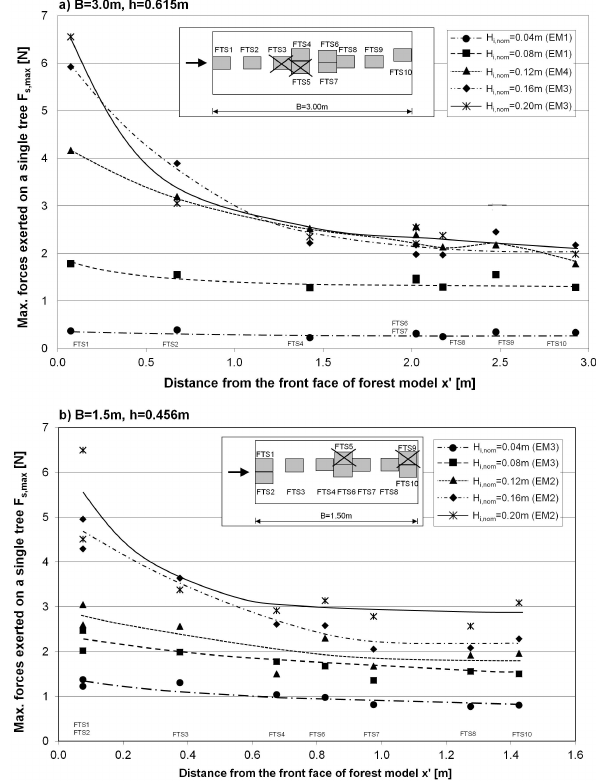
Fig. 10. Selected envelopes of bore height: (a) water depth behind bore gate h o = 0.8m and water depth in front of bore gate h 1 = 0m, (b) water depth behind bore gate h o = 0.6m and water depth in front of bore gate h 1 = 0.3m.